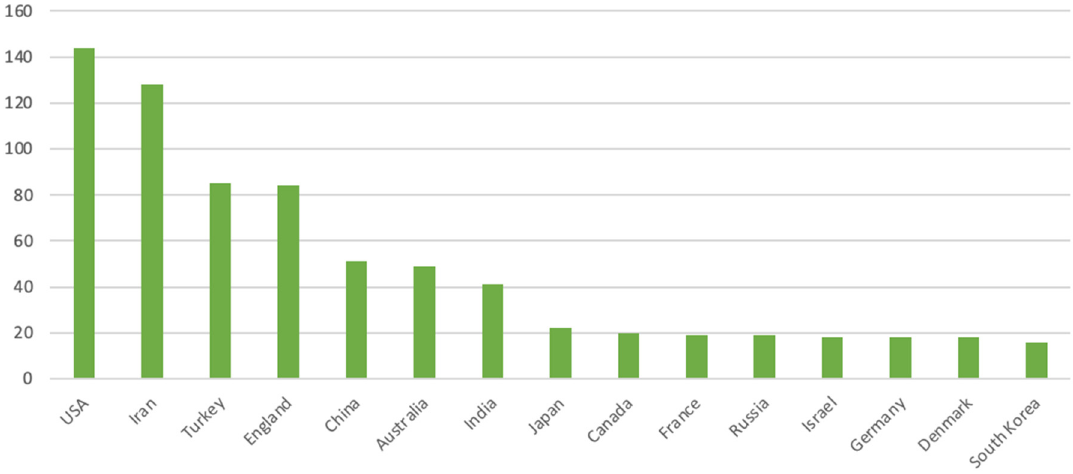
Figure 4. The top 15 countries for foot reflexology paper production. Table 2. Clusters of published papers by country and research topic.